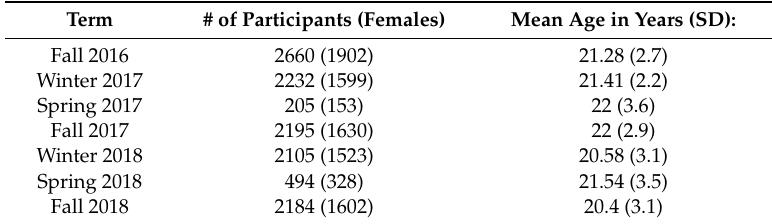
Table 1. Participant Breakdown by